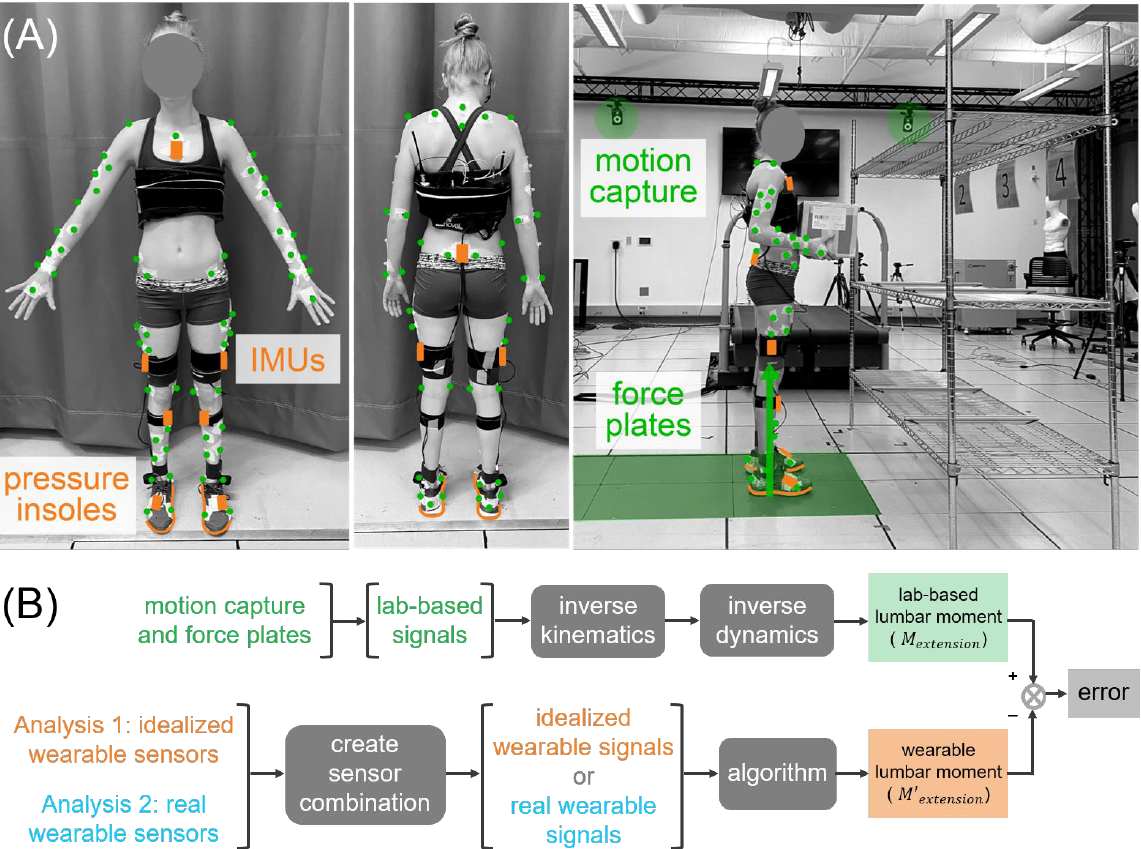
Figure 1. Experimentation and wearable algorithm development overview. ( A ) Lab-based (green) and wearable sensor (orange) signals were collected synchronously in a motion analysis lab while participants performed about 400 manual material handling tasks. ( B ) Lab-based analysis yielded a gold-standard estimate of lumbar extension moment ( M extension ). Wearable signal analysis and algorithm development yielded wearable sensor estimates of lumbar extension moment ( M’ extension ). The wearable algorithm development was conducted twice, once using idealized wearable sensors (defined in Methods) as inputs (Analysis 1) and once using real wearable sensors as inputs (Analysis 2).